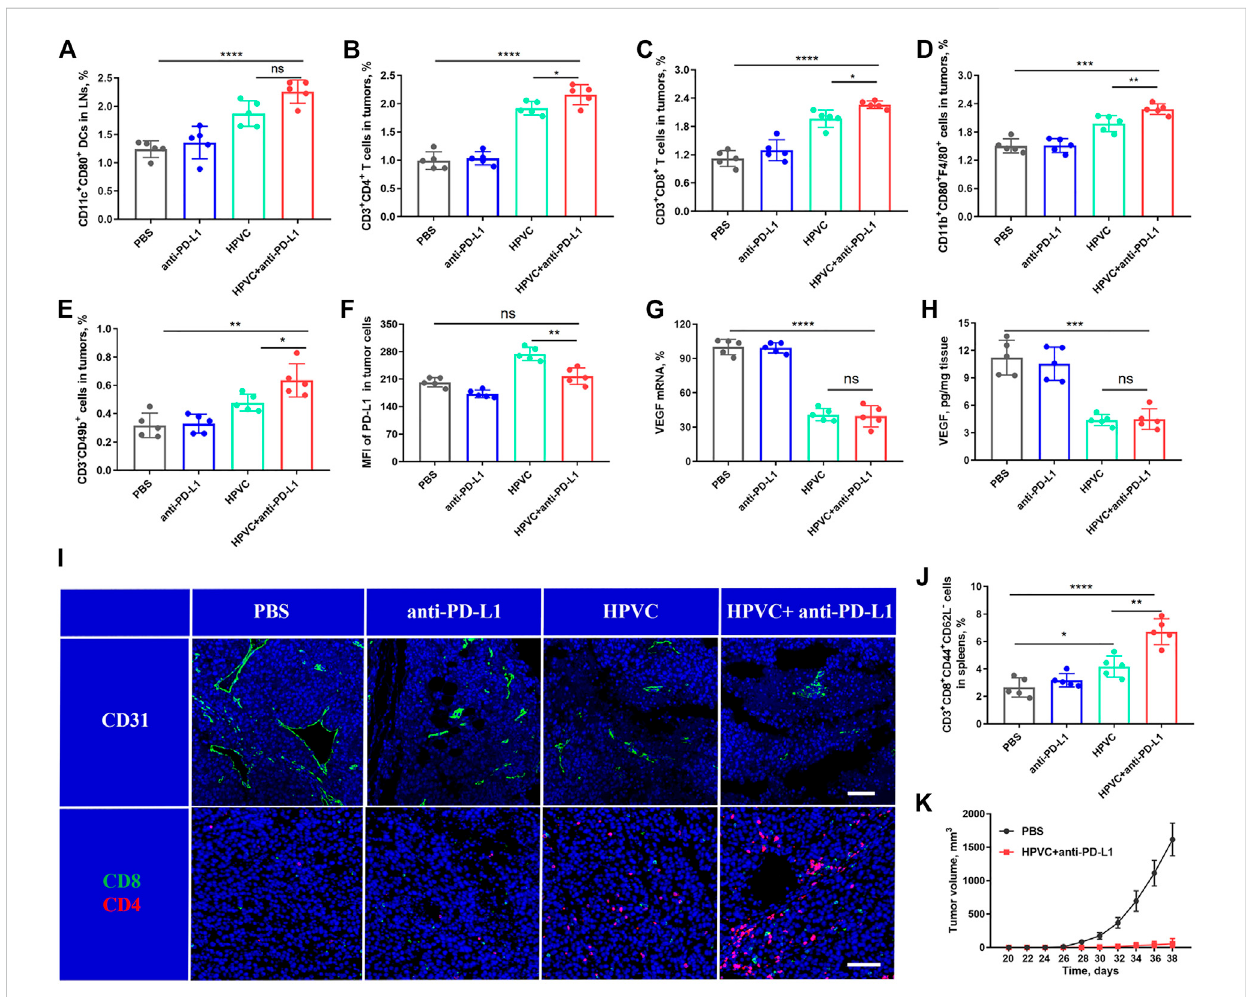
FIGURE 6 Analysis of immune cells after treatment. (A) DC maturation in LNs. (B) CD3 + CD4 + T cells in tumors. (C) CD3 + CD8 + T cells in tumors. (D) CD11b + CD80 + F4/80 + macrophages in tumors. (E) CD3 − CD49b + NK cells in tumors. (F) Mean fl uorescence intensity (MFI) of PD-L1 expression in tumor cells. (G) VEGF mRNA expression in tumors on day 19 by RT ‒ qPCR assay. (H) VEGF protein expression in tumors on day 19 by ELISA. (I) Representative images of CD31 + (green), CD8 + T cells (green) and CD4 + T cells (red) by immuno fl uorescence staining. Nuclei were stained with DAPI (blue).